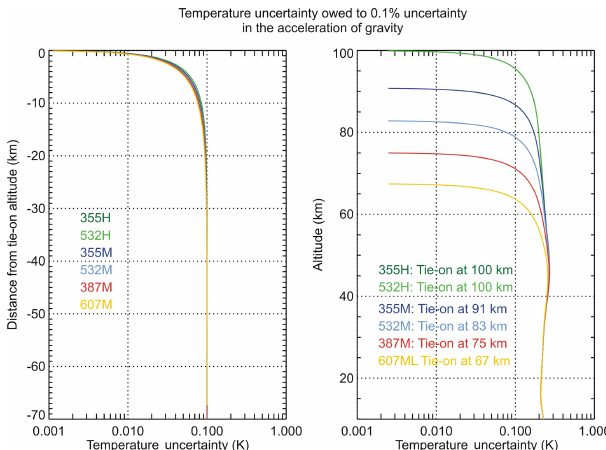
Figure 9. Temperature uncertainty owing to 0.1% uncertainty in the acceleration of gravity. Left: relative uncertainty (%) as a function of the distance from the tie-on altitude. Right: absolute uncertainty (K) as a function of